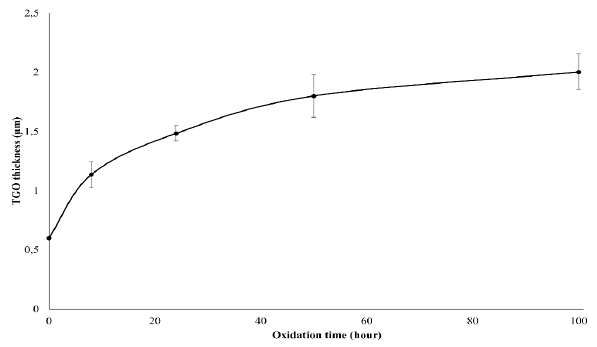
Figure 3: Variation of TGO layer thicknesses depending on the increasing